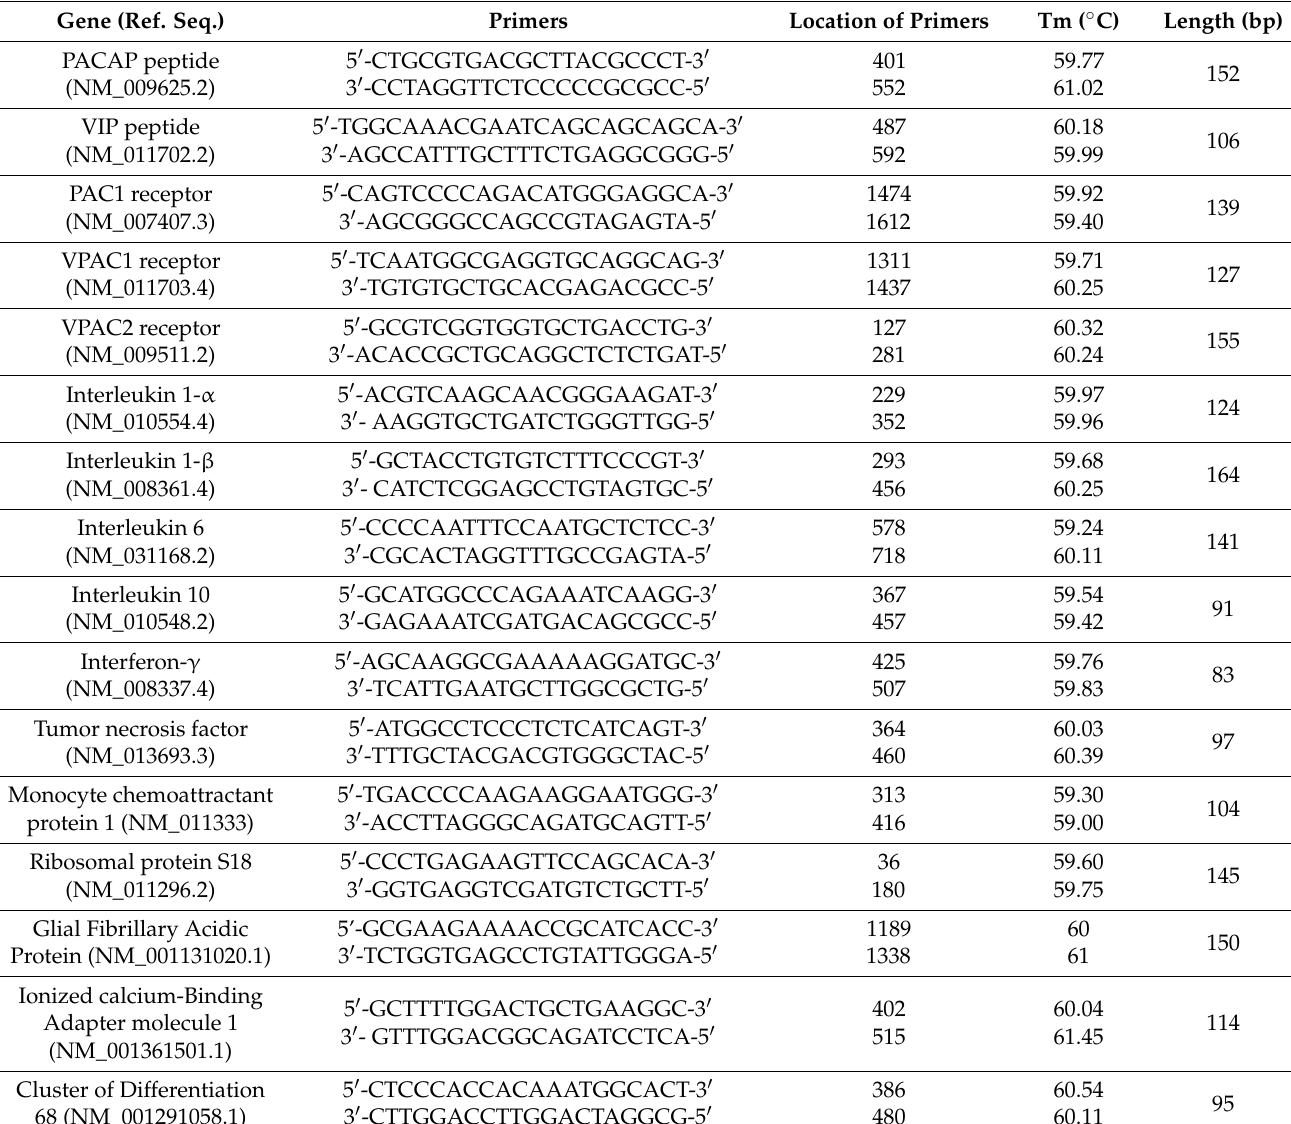
curve analysis. Table 1. Primer sequences targeting the PACAP/VIP system and the inflammatory markers optimized for real-time quantitative PCR. Predicted amplicon lengths are indicated in base pairs (bp). Gene (Ref.